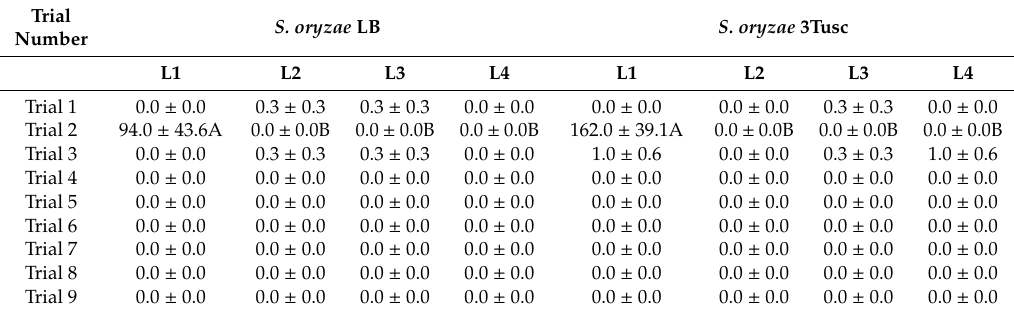
Table 5. Progeny production (mean number of adults ± SE / vial) in vials containing parental adults of two populations of S. oryzae (LB, 3Tusc), with di ff erent susceptibility to phosphine, exposed to nitrogen in nine di ff erent trials (for conditions for each trial, see Table 1). For each trial, vials with insects were placed in four di ff erent locations (L1–L4, see Table